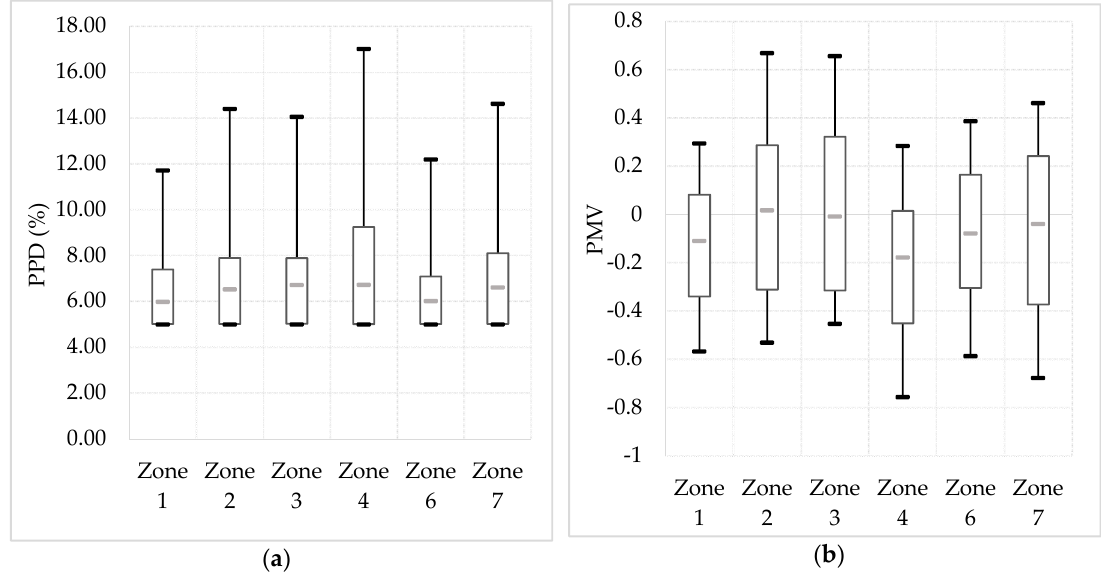
Figure 8. Median, minimal, maximal and (10th–90th) percentiles of: ( a ) the PPD; and ( b ) the PMV for each zone for the month of January